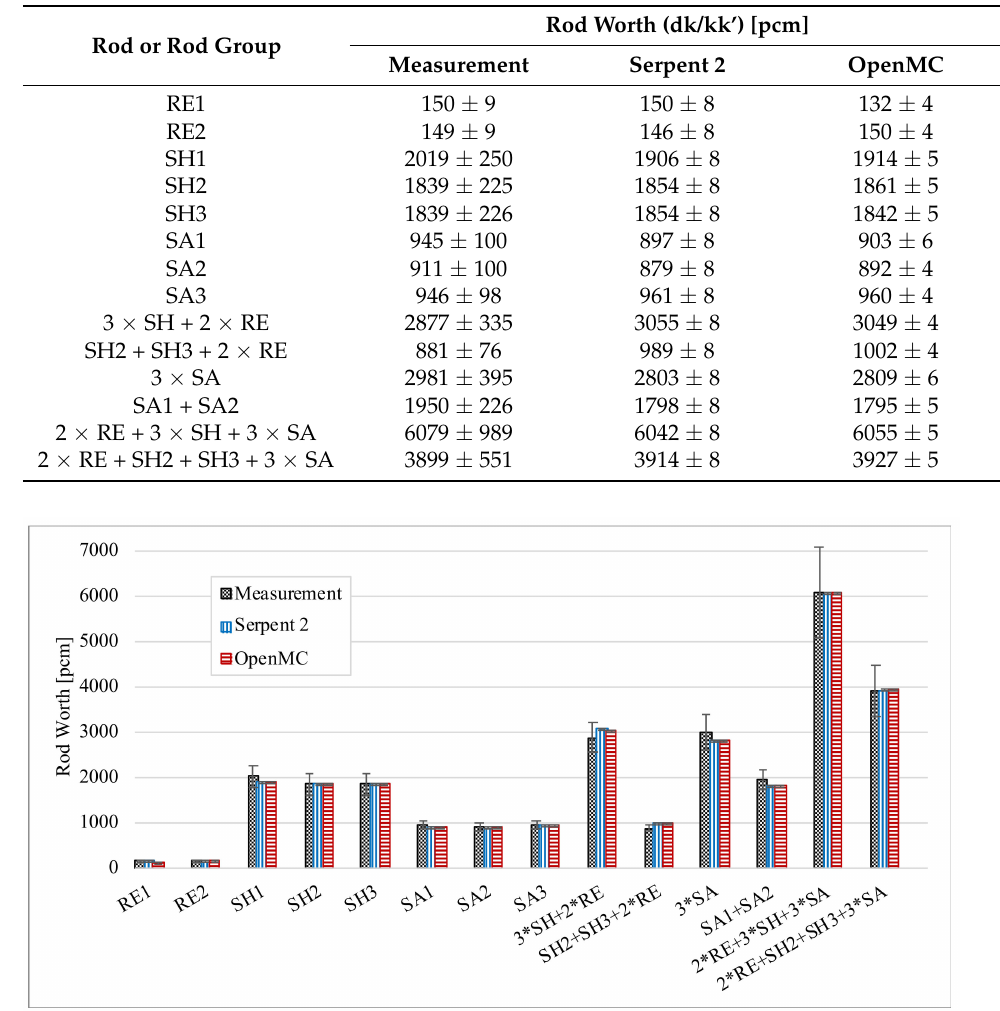
Table 4. Results of Control-Rod Worth.